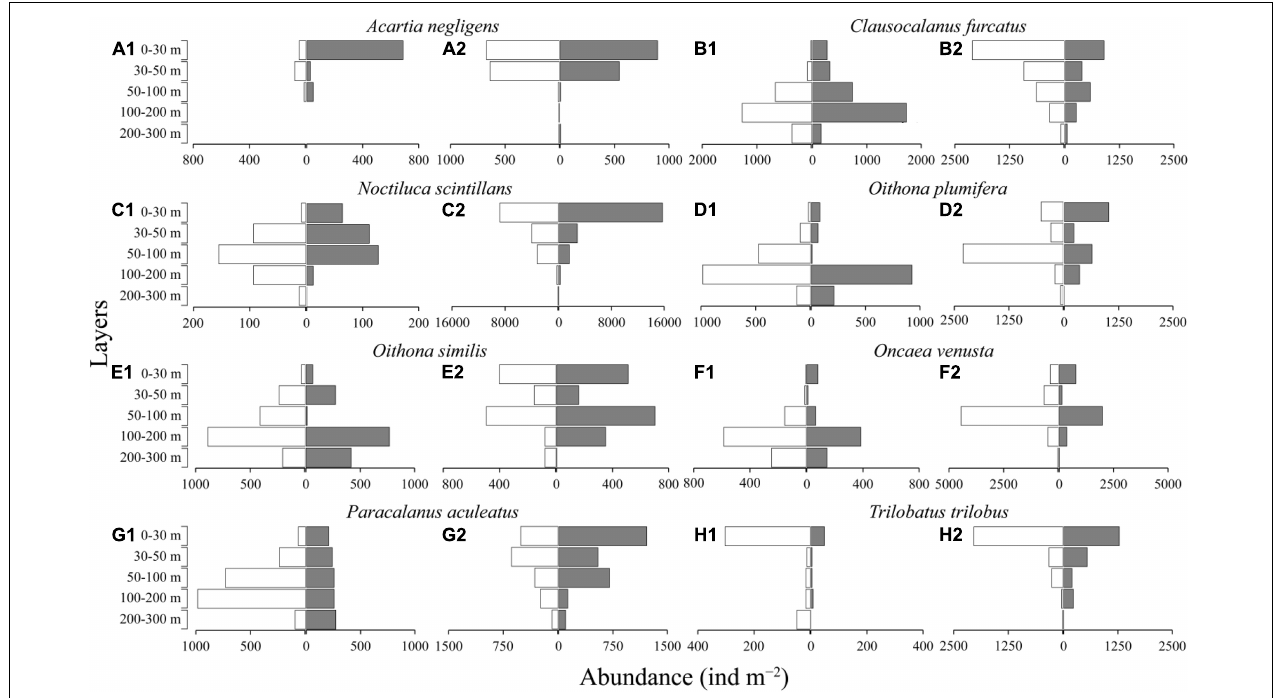
FIGURE 5 | Diel vertical distribution of mesozooplankton dominant species at two fixed stations (white, daytime; gray, nighttime; 1, station A; 2, station B). TABLE 2 | Total biomass of mesozooplankton and downward active fluxes below the depth of 200 m.